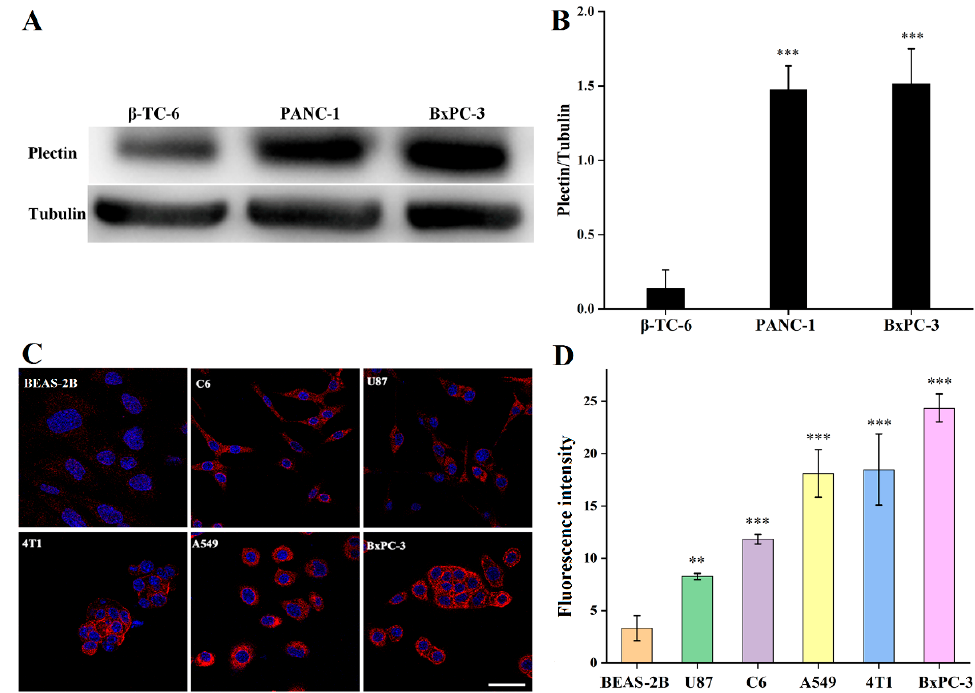
Figure 1. ( A ) Western blot results of plectin and ( B ) densitometry values in β -TC-6, PANC-1, and BxPC-3 cells. ( C ) Immunofluorescence staining of plectin and ( D ) quantitative analysis in different cell lines (BEAS-2B, BxPC-3, C6, U87, A549, and 4T1). The scale bar represents 50 µm for all panels. (**) for p < 0.01, (***) for p < 0.001.